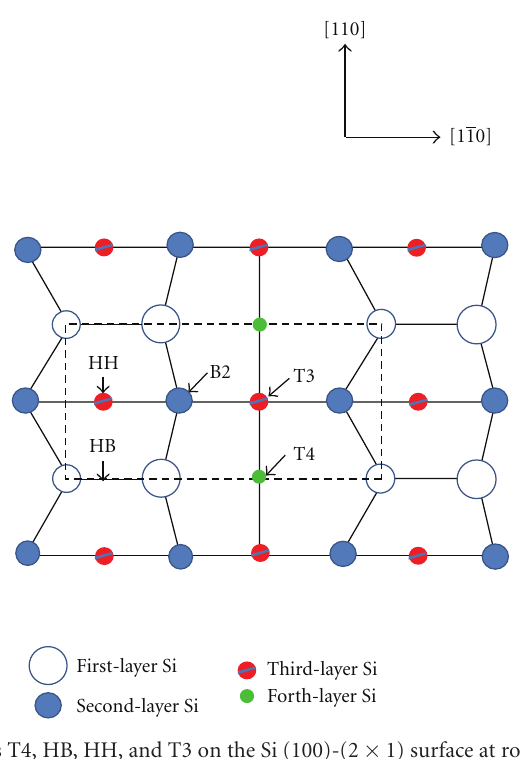
Figure 1: The initial Co adsorption sites T4, HB, HH, and T3 on the Si (100)-(2 × 1) surface at room temperature. B2 is the “cave site” for Mg mentioned in Section